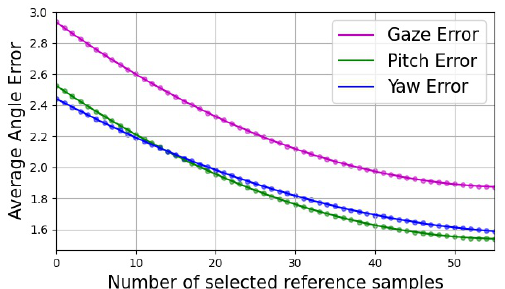
Figure 10. The angle errors using different numbers of reference images from the UT-Multiview